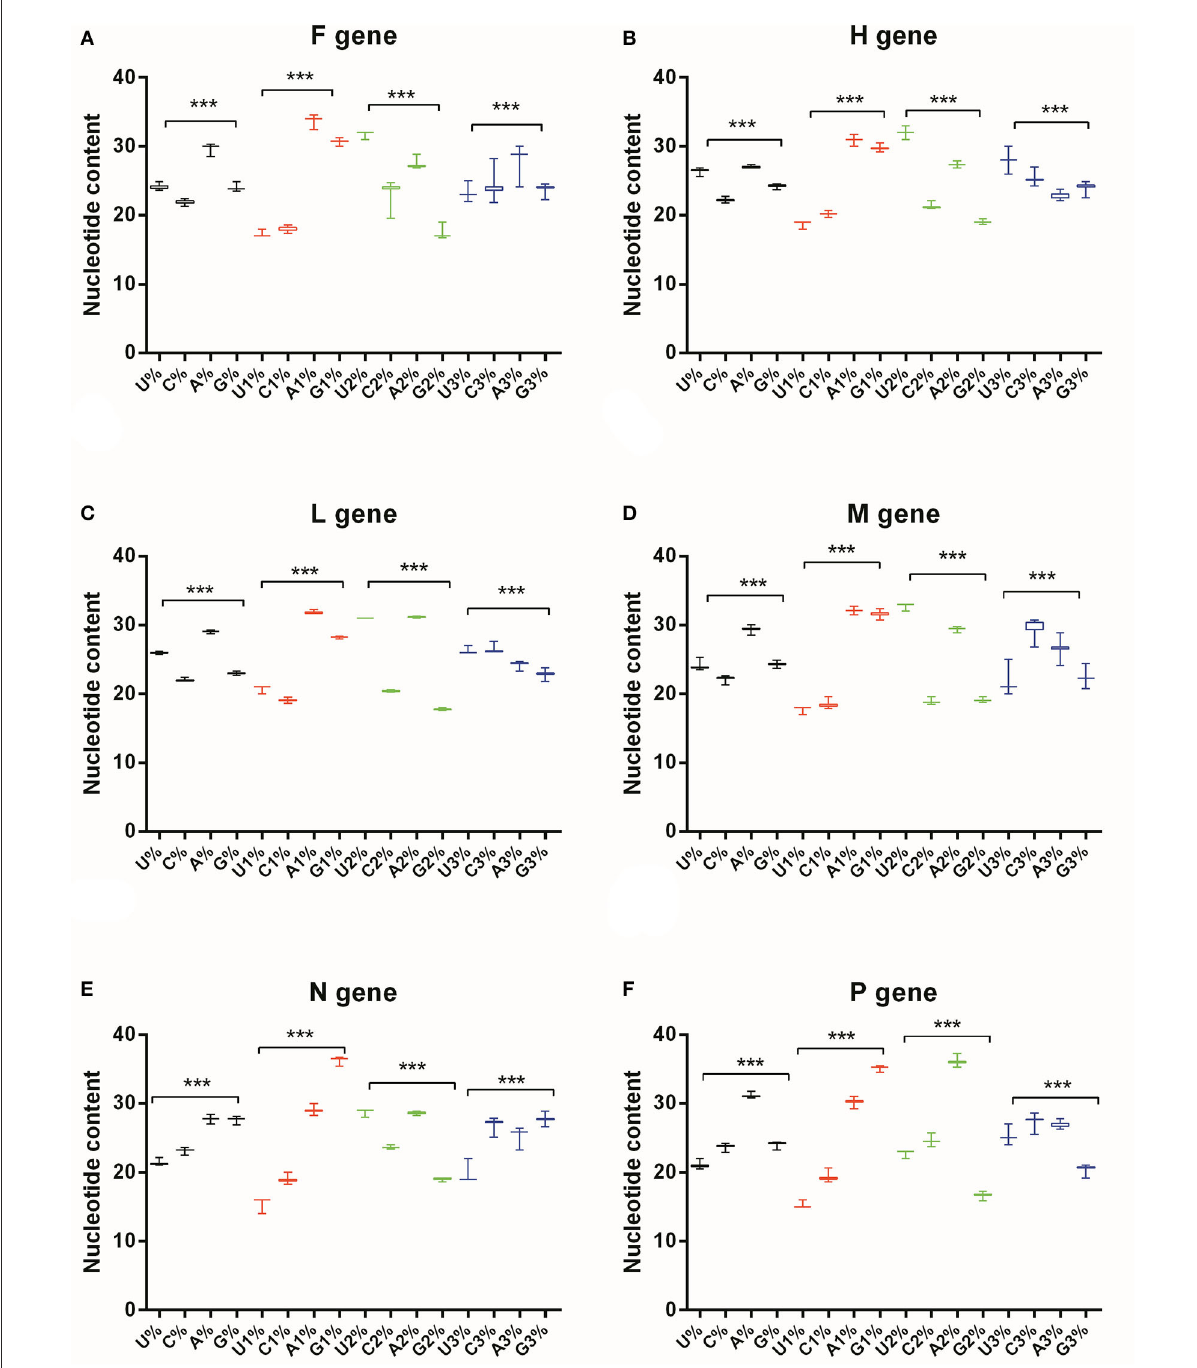
FIGURE1 Nucleotide content of PPRV coding sequences and different codon positions. U, C, A, and G% are the overall nucleotide content of coding sequence; U1, C1, A1, and G1% are nucleotide content in the first codon position; U2, C2, A2, and G2% are nucleotide content in the second codon position; U3, C3, A3, and G3% are nucleotide content in the third codon position. The One-way ANOVA method is used for estimating the differences of nucleotide usage patterns. (A) F gene, (B) H gene, (C) L gene, (D) M gene, (E) N gene, (F) P gene. When p -value < 0.05, it means a significant difference between the given groups. Of note, because all analyses of One-Way ANOVA in this figure produce p -values < 0.001, they are remarked as